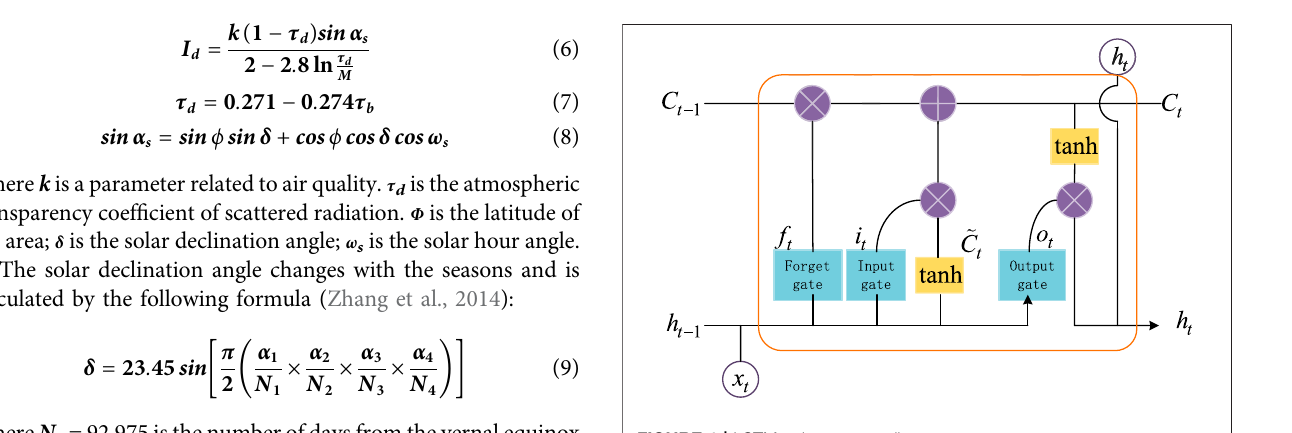
FIGURE 1 | LSTM unit structure